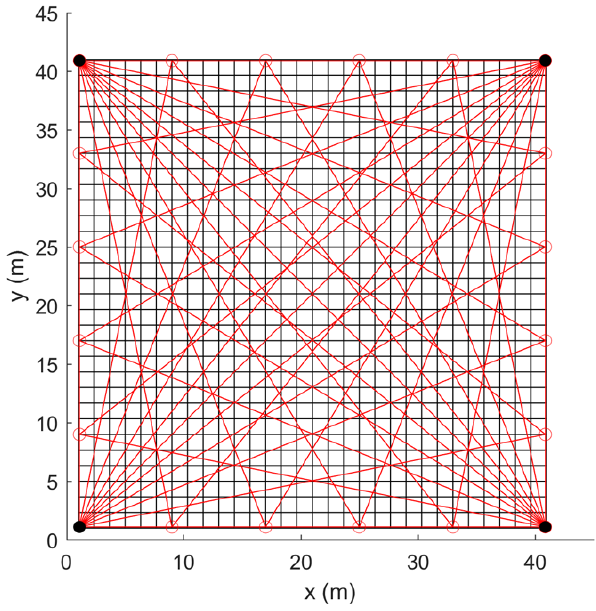
Figure 2. Beam geometry and a 30 × 30 grid division of the